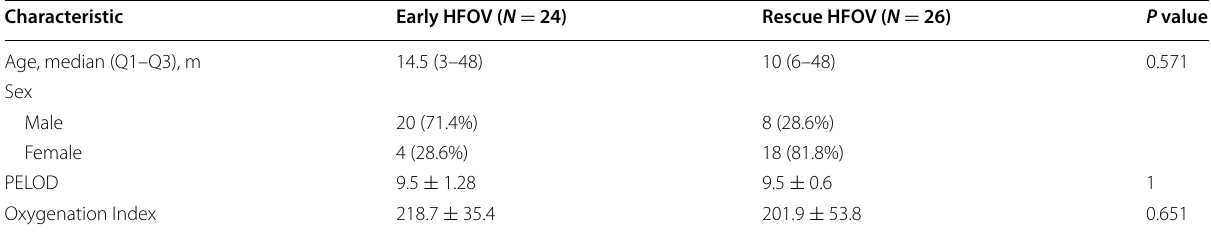
Table 1 Baseline characteristics of patients